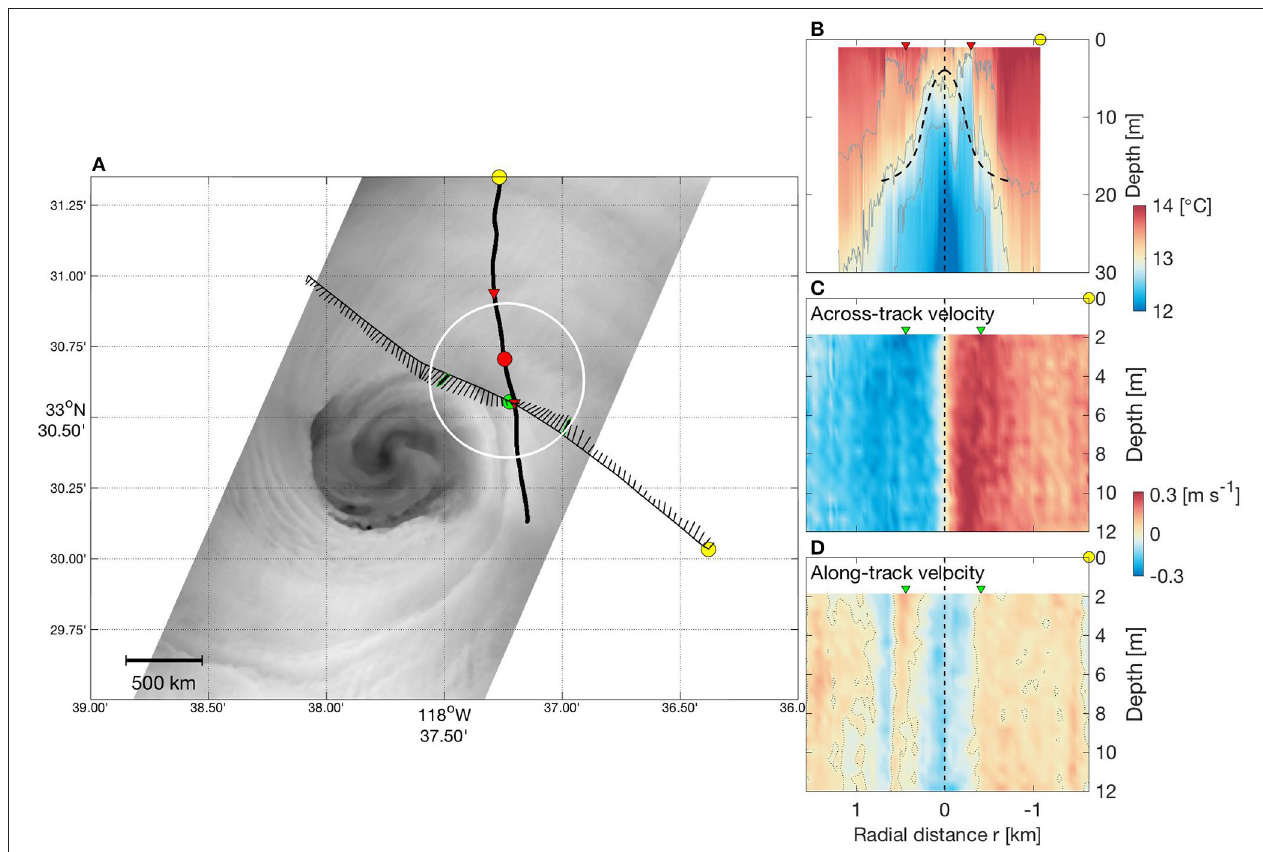
FIGURE 5 | Representative in-situ data. (A) Nearly simultaneous sampling tracks of the R/V YellowFin (curve with 2-m depth velocity vectors; 2259–2315 UTC) and the Zodiac (bold curve; 2302–2309 UTC). The image shows the final IR overpass, which was made about 2h earlier (2113 UTC). A 1-km-diameter circle indicates the eddy’s approximate location at the time of the boat measurements. Yellow dots show the beginning location of the boat transects; the red dot is the eddy center estimated from the temperature data, and the green dot from the across-track velocity. (B) Vertical temperature section plotted against distance from the eddy center. Red triangles indicate maxima in surface temperature gradient. Superimposed dashed curve shows modeled depth of 13 ◦ C isotherm, using Equation (5) in the text. (C,D) Vertical sections of across-track and along-track velocity components, plotted against distance from the eddy center. For reference, green triangles indicate maxima in across-track